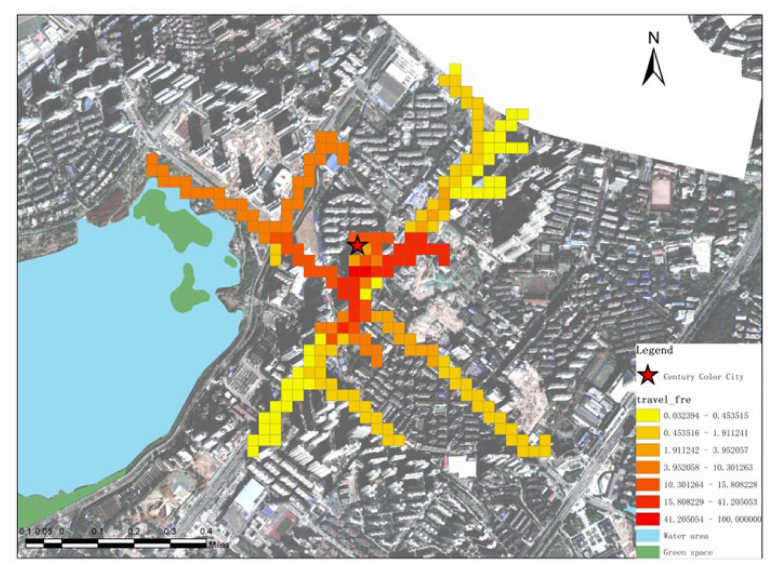
Figure 11. Century Color City residents’ travel characteristic.